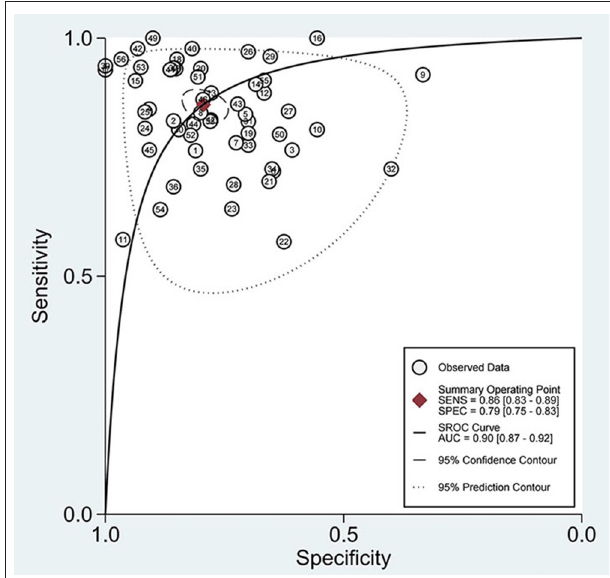
FIGURE 4 | SROC curves based on all miRNAs.